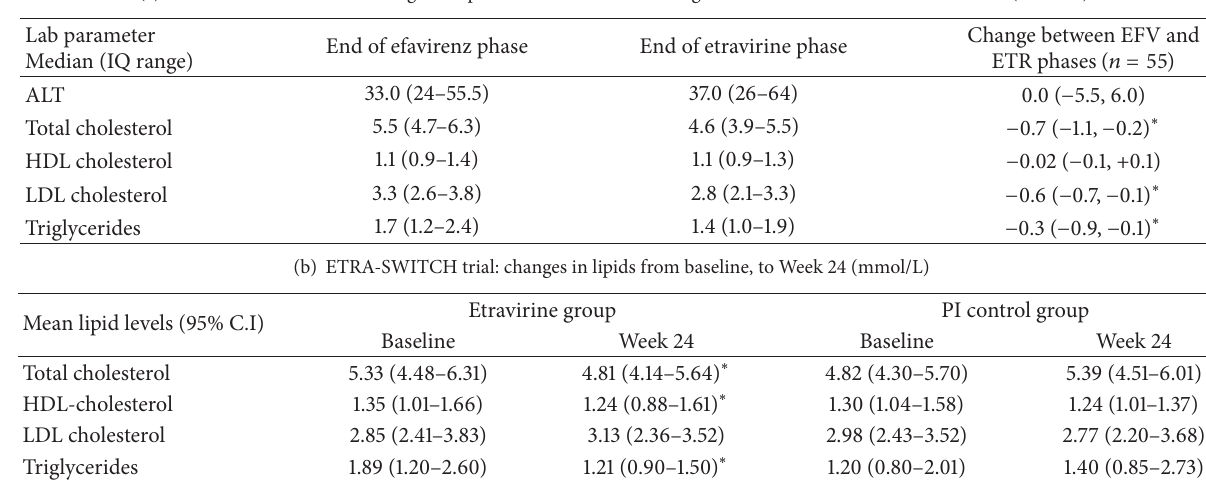
Table 5: Changes in metabolic parameters in the Swiss SWITCH-EE trial and the Spanish ETRA-SWITCH trial. (a) Swiss SWITCH-EE trial: changes in lipids six weeks after switching from efavirenz to etravirine treatment (mmol/L) Lab parameter